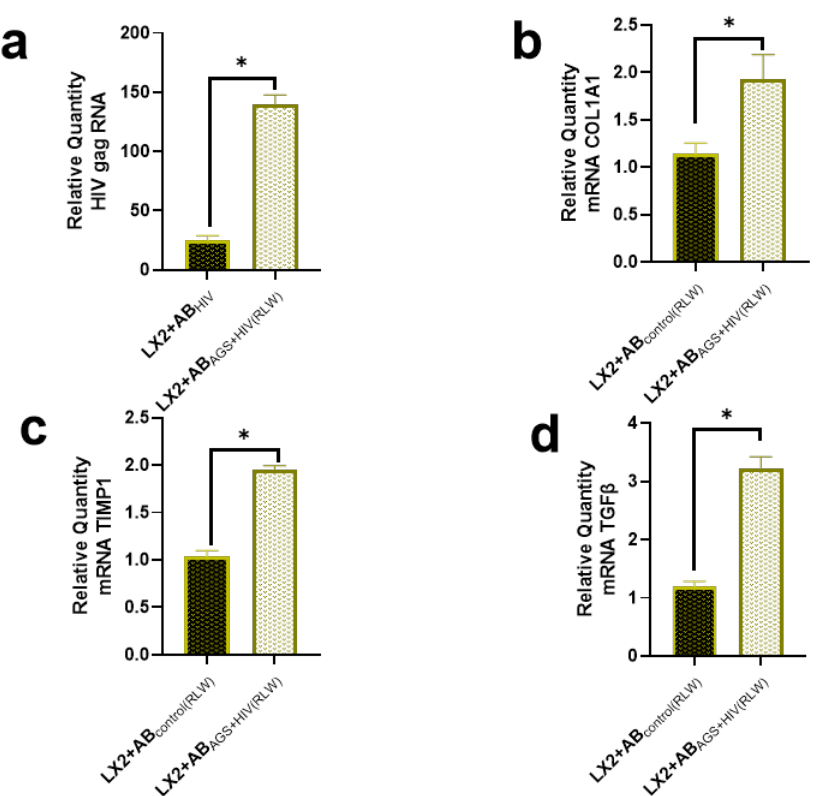
Figure 1. ABs derived from AGS-treated and HIV-infected RLW cells enhance HIV expression in LX2 cells as well as induce profibrotic changes: ( a ) RT-PCR analysis of HIV gag RNA expression in LX2 cells after internalization of AB AGS+HIV . RT-PCR analysis of ( b ) COL1A1 mRNA, ( c ) TIMP1 mRNA, and ( d ) TGF β 2 mRNA of LX2 cells exposed to RLW AB AGS+HIV for 2 h. Bars with * are significantly different from each other at p ≤ 0.05. Data were generated from 3 independent experiments.